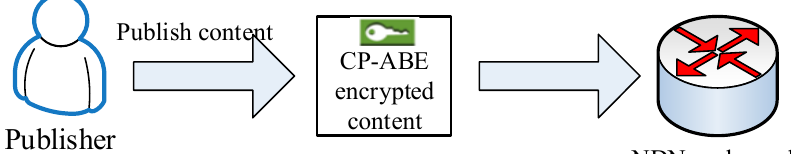
Figure 3. Content release process.